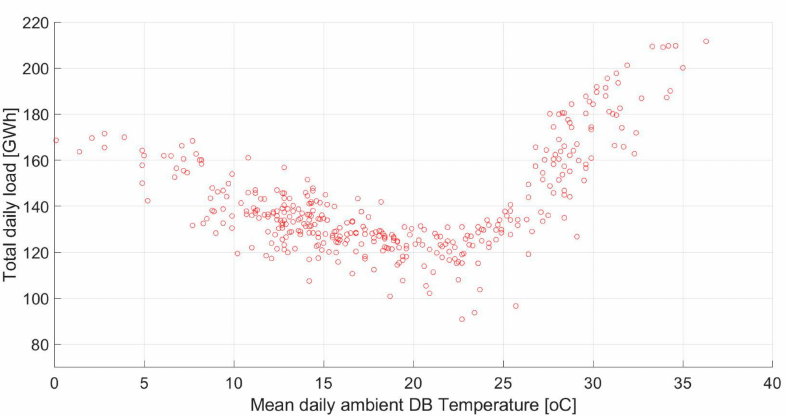
Figure 9. Correlation of the total daily electricity load in GWh with the daily mean temperature (DB) of Psychico weather station (year